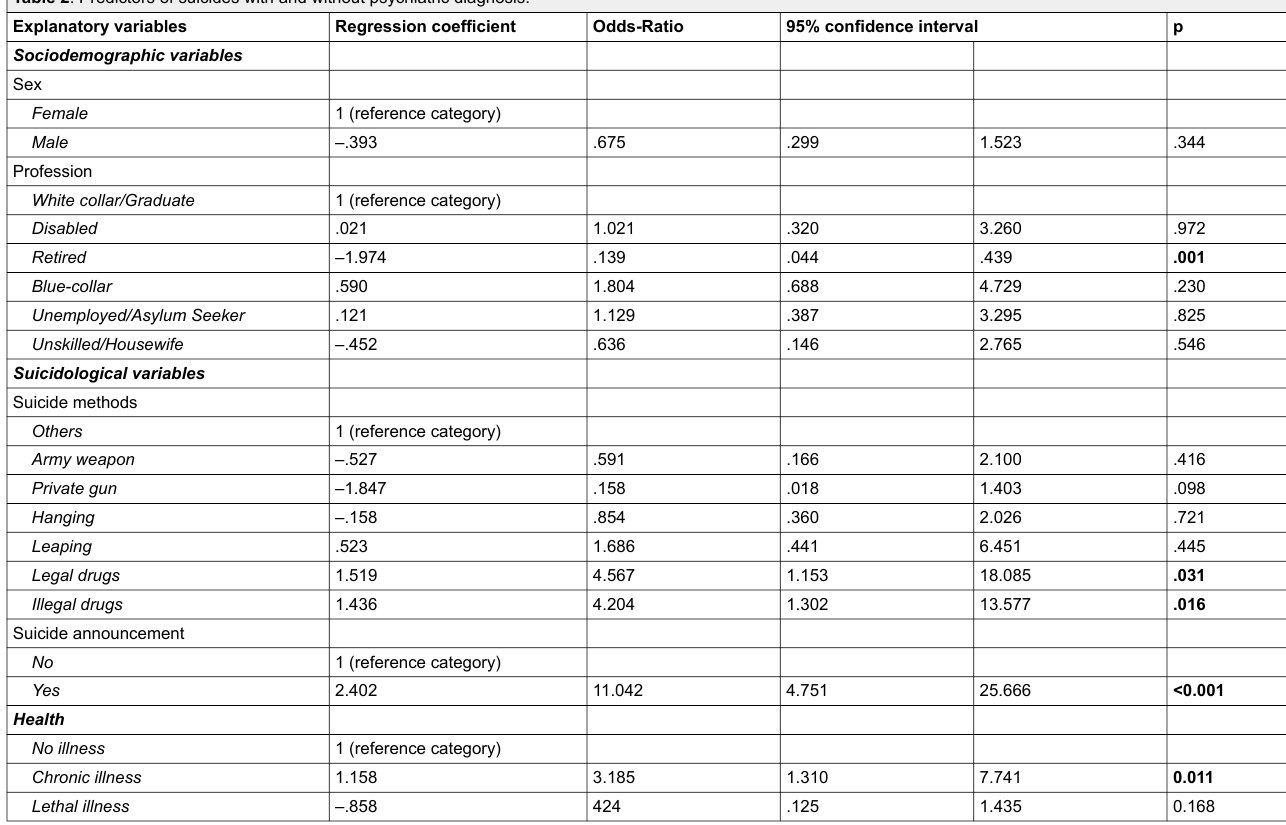
Table 2 : Predictors of suicides with and without psychiatric diagnosis. Explanatory